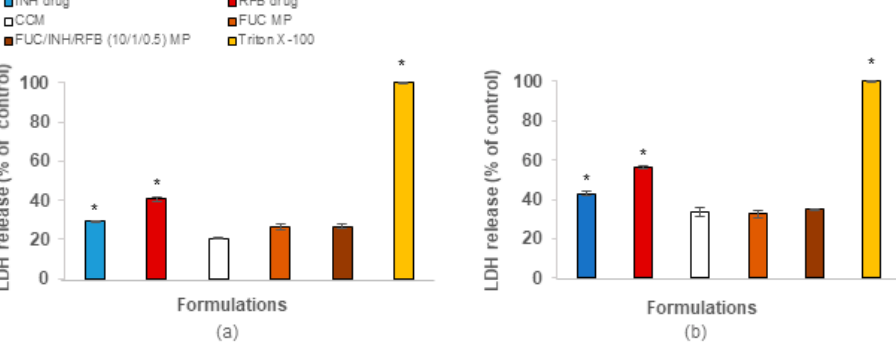
Figure 6. Release of lactate dehydrogenase (LDH) from ( a ) A549 cells and ( b ) macrophage- differentiated THP-1 cells exposed to fucoidan-based microparticles (1.0 mg/mL), free rifabutin (RFB, 0.05 mg/mL), and free isoniazid (INH, 0.1 mg/mL). Cell culture medium (CCM) and Triton X-100 were used as negative and positive controls, respectively. The released LDH calculated was based on 100% assumed for positive control. Data represent mean ± SEM ( n = 3, six replicates per experiment at each concentration). * p < 0.05 compared to